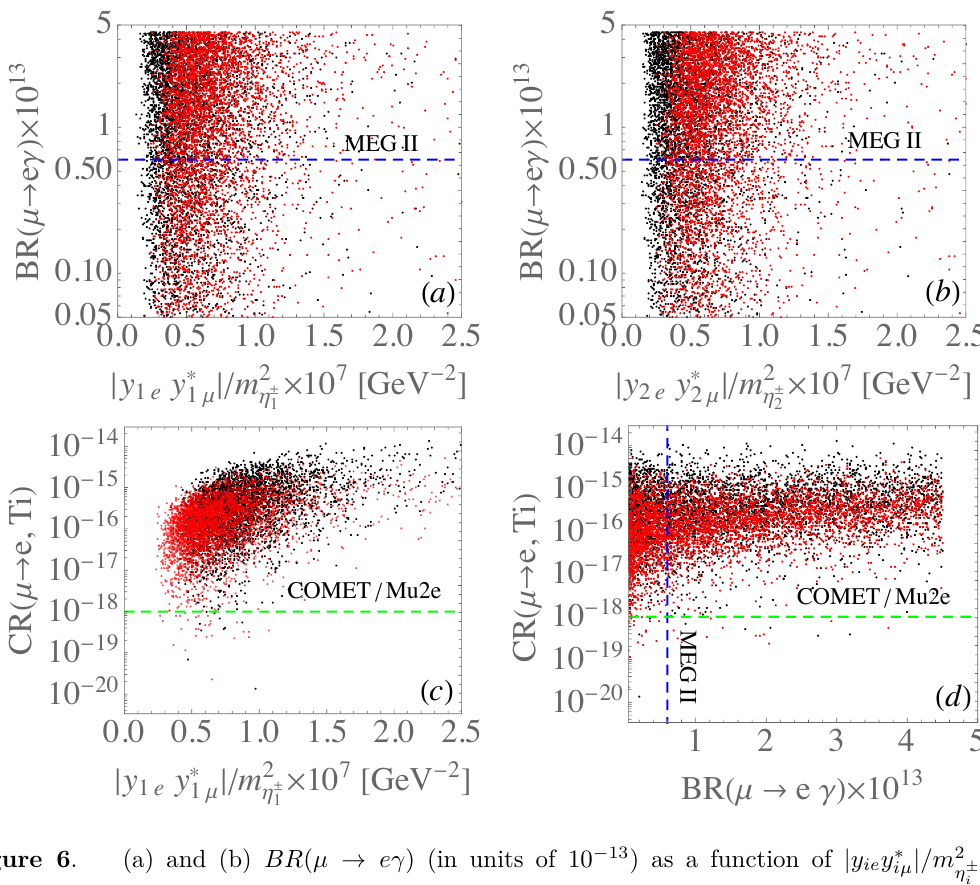
; and (d) correlation between BR ( µ → eγ ) and | /m 2 1 µ η ± 1